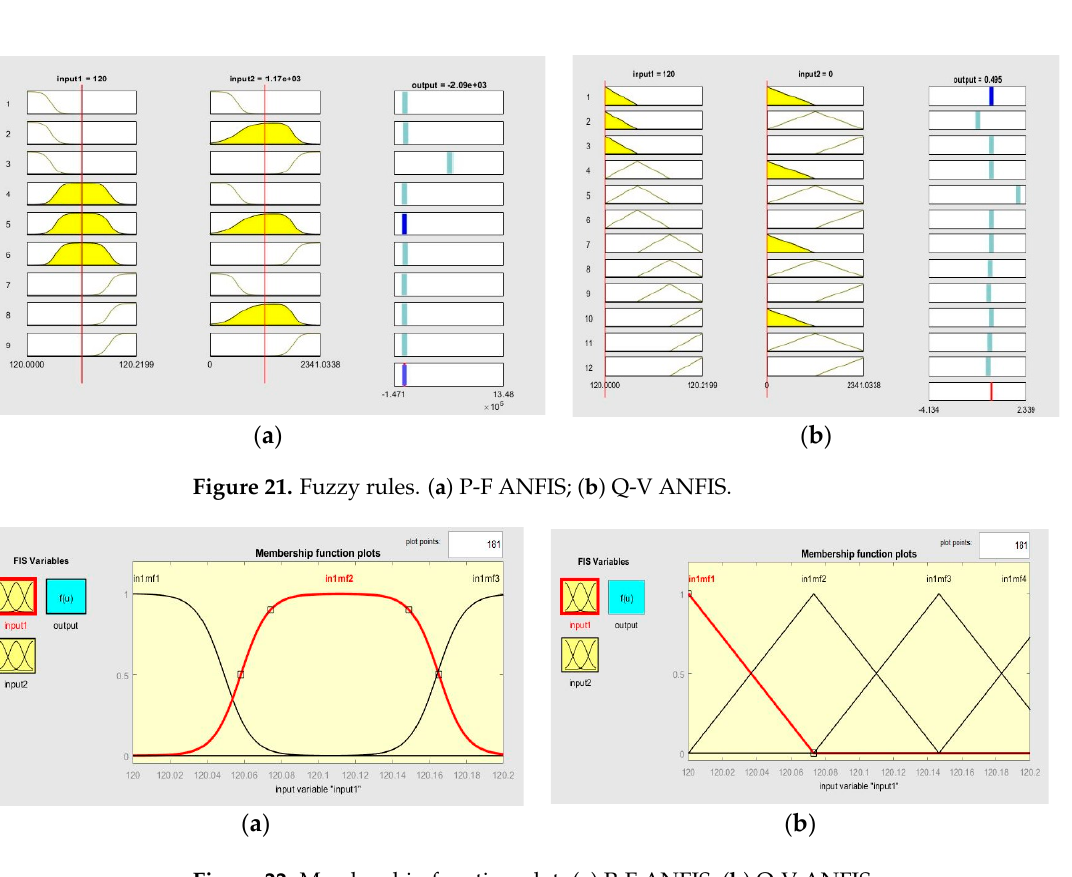
Figure 22. Membership function plot. ( a ) P-F ANFIS; ( b ) Q-V ANFIS.